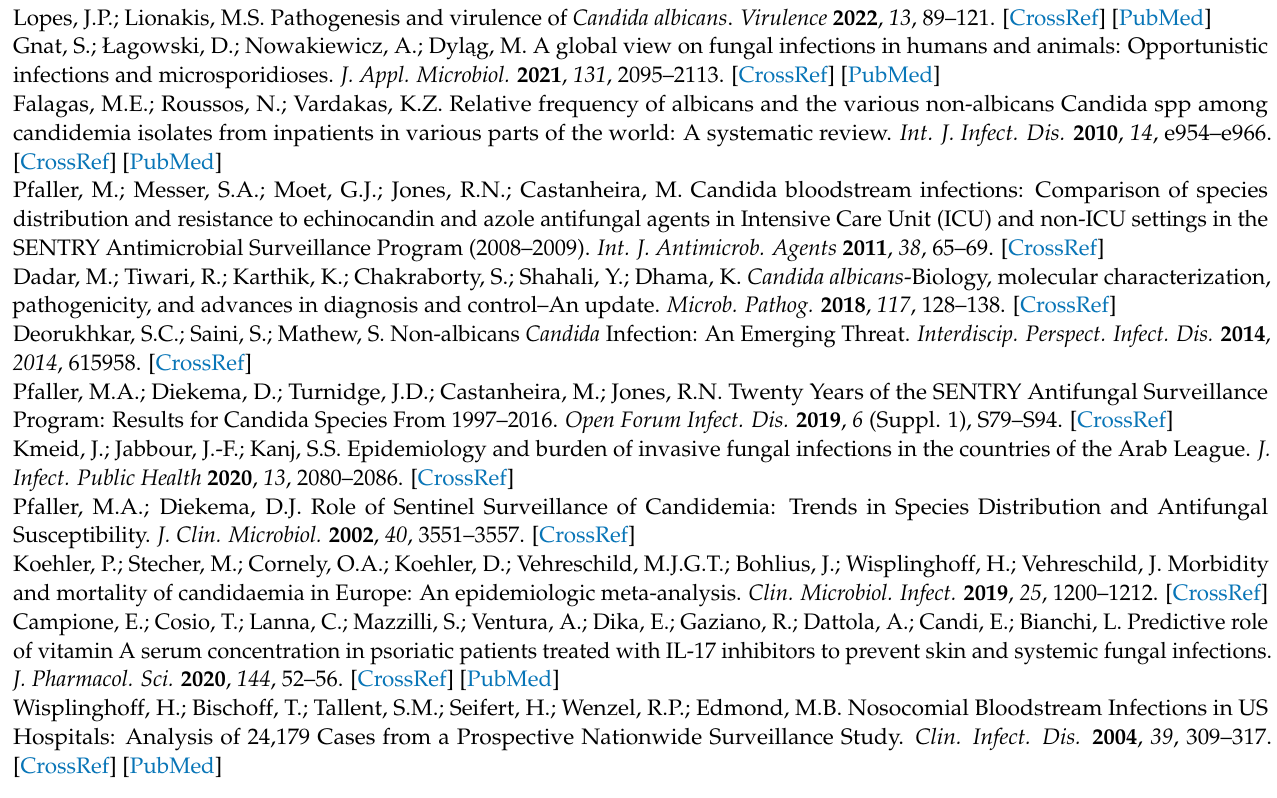
strain SC5314; Table S1: Isolate numbers of each Candida species identified by different methods; Table S2: MIC of Fluconazole against isolated Candida species by broth microdilution method (n = 109); Table S3: MIC of Amphotericin B against of Candida species isolated from blood using the broth microdilution method (n =